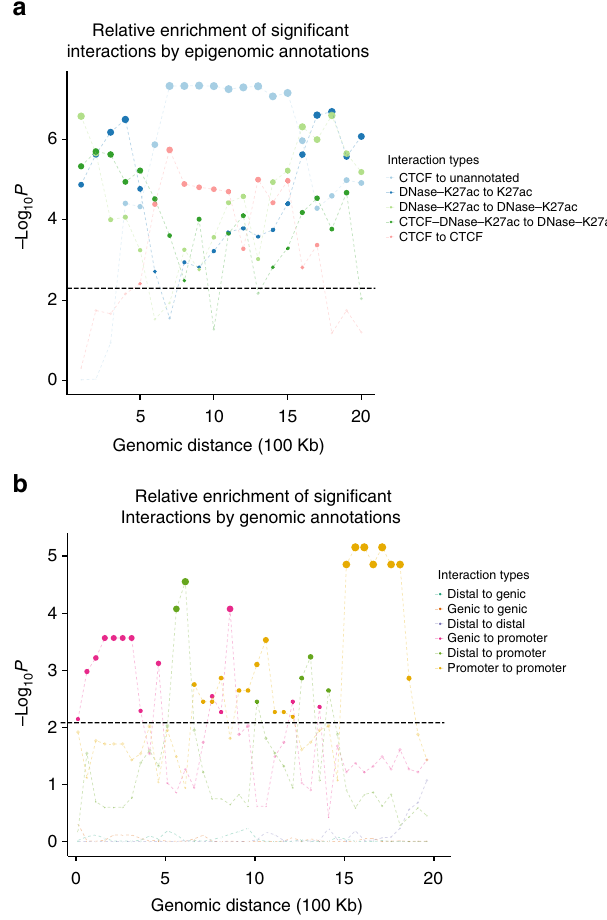
Figure 3 | Distinct classes of structural and regulatory interactions occur at different distance ranges. ( a ) Relative enrichments of significant HiC-DC interactions (FDR o 1%) for the Rao et al. 11 GM12878 data as annotated by epigenetic signals, as a function of genomic distance. For each 10kb band, enrichment of interactions with each specific annotation were computed relative to the background prevalence of this annotation (by Fisher’s exact test), and then the enrichment P values for each annotation over 100kb distance subranges were compared to all other annotations (Methods section). ( b ) Relative enrichments of significant HiC-DC interactions (FDR o 1%) for the Rao et al. 11 data as annotated